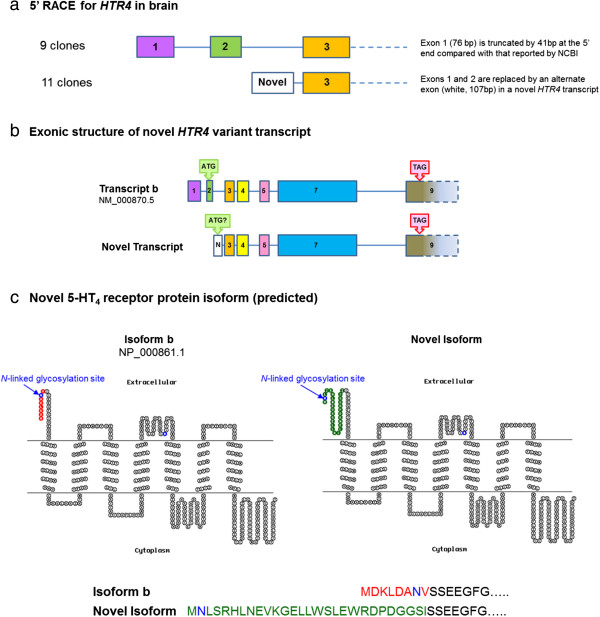
Analysis of HTR4 gene structure and identification of a novel transcript variant in brain. 5′ RACE in cDNA derived from total brain tissue indicated expression of transcripts possessing exons 1-3, and also a novel transcript in which exons 1 and 2 are replaced by an alternate exon (a). The remaining sequence of the novel transcript aligns with the equivalent region of transcript b (b). The predicted protein structure of this novel variant has an elongated N-terminus and affects the position of an N-linked glycosylation site in this region (c).